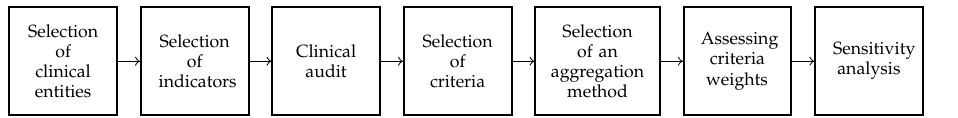
Figure 1. The conceptual model of the process for identifying the top 40% best-performing public acute hospitals in